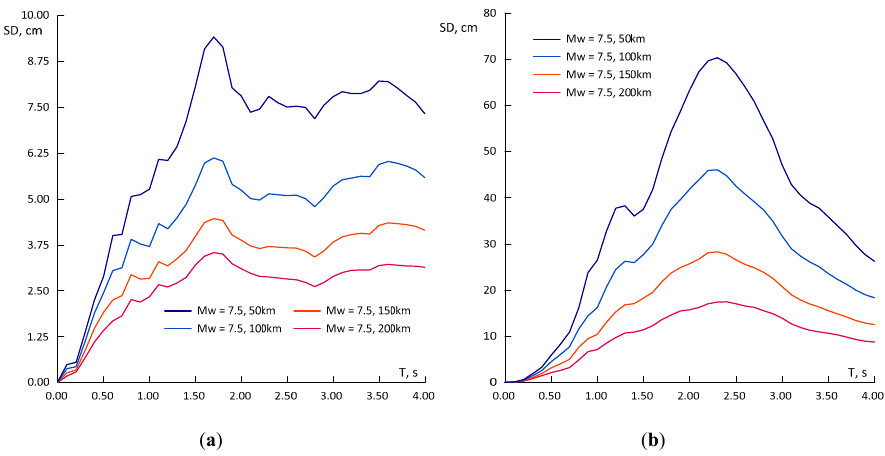
Figure 9. Displacement spectra for an event with M W = 7.5 and 50, 100, 150, 200 km epicentral distances. ( a ) ground type B; ( b ) ground type C.